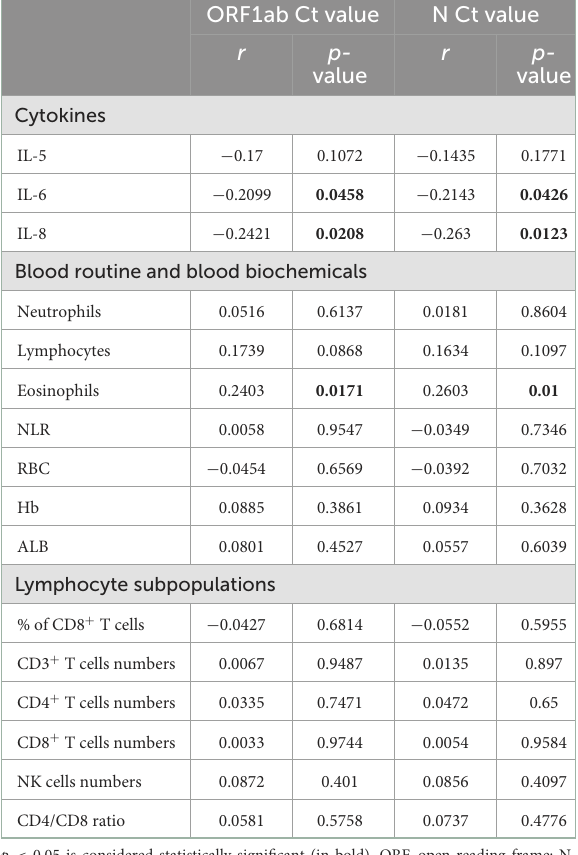
TABLE 5 Correlation between ORF1ab/N gene Ct values and laboratory findings in COVID-19